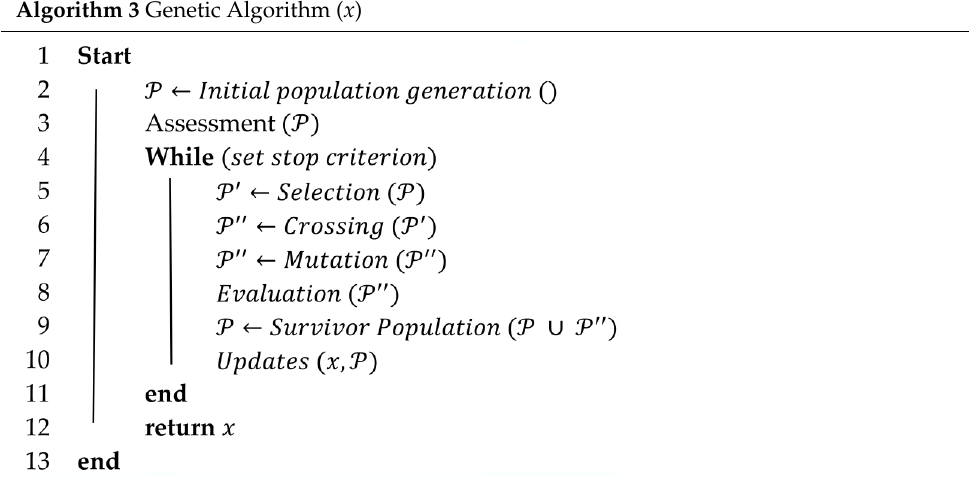
Algorithm 3 Genetic Algorithm ( x